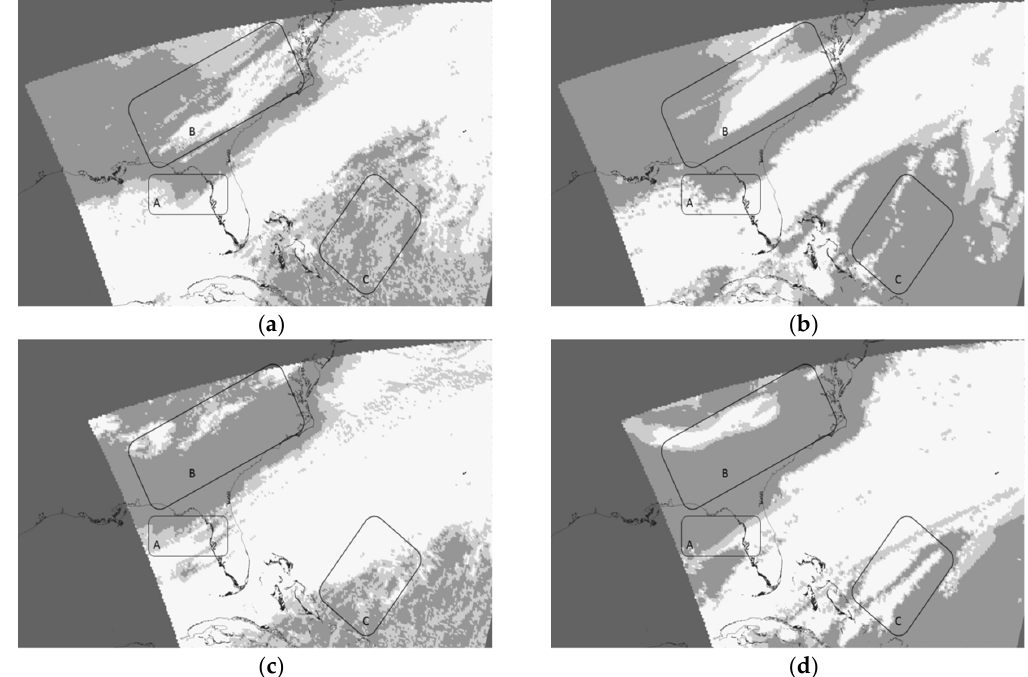
Figure 3. Comparisons between CCf truth and CCf NAM at 1800 UTC. ( a ) Mean CCf truth for all clouds in the VIIRS data on 18 Nov 2014 after mapping the MGCNC image to the NAM grid and ( b ) CCf NAM for all clouds in the NAM dataset. Similar images for 19 Nov 2014 are shown in ( c ) and ( d ) respectively. In all images, coastlines are the black followed by background and mostly cloudless ( < 10%) conditions which are darker gray, partly cloudy (10–90%) areas which are lighter gray and cloudy grids ( > 90%) which are white.